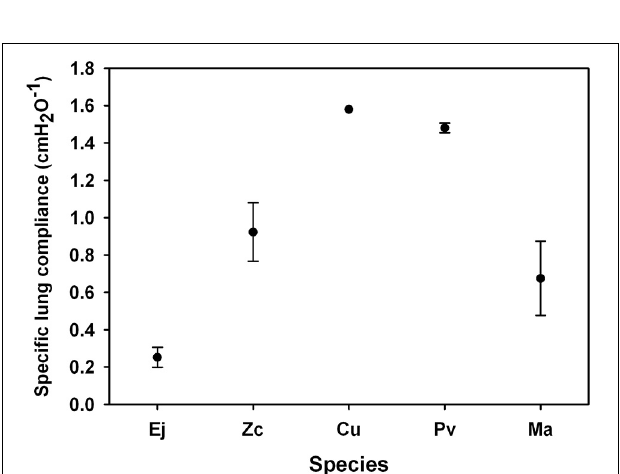
FIGURE 1 | Relationship between transpulmonary (airway pressure minus esophageal pressure) or chest wall pressure (esophageal pressure minus ambient pressure) and inspired volume expressed as a percent of estimated total lung capacity (Fahlman et al., 2011) for 3 individual California sea lions ( Zalophus californianus ).